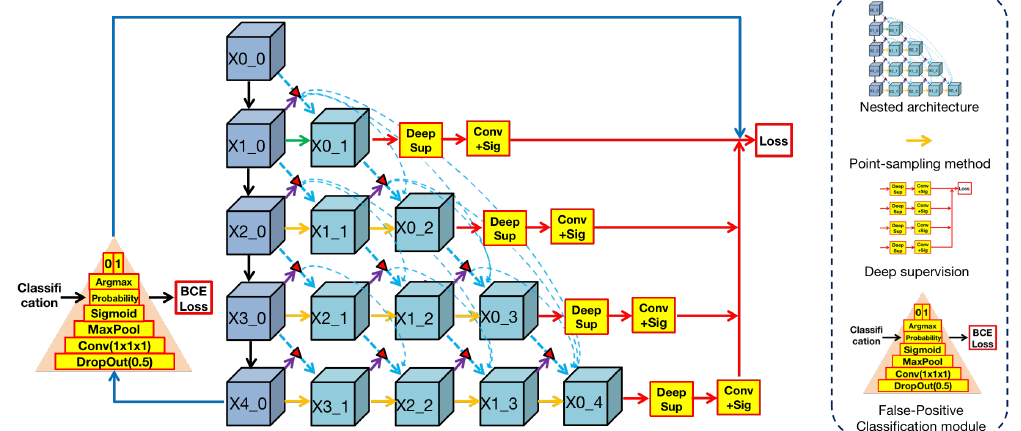
Figure 2. Overview of methodologies in Render 3D U-Net: the nested architecture is analyzed in Section 3.1. The point-sampling method is analyzed in Section 3.2. The false-positive classification module is analyzed in Section 3.3.